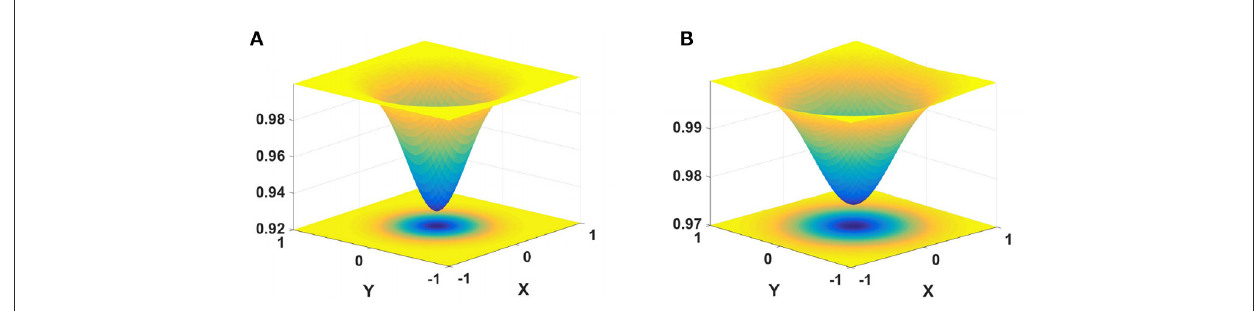
FIGURE3 Schematic illustration of cell inhibition. On the left is the nearest neighbors convolution kernel, and on the right is the next-nearest neighbors convolution kernel. (A) σ 1 = 0.3, F 1 = 5, (B) σ 2 = 0.4, F 2 = 1.